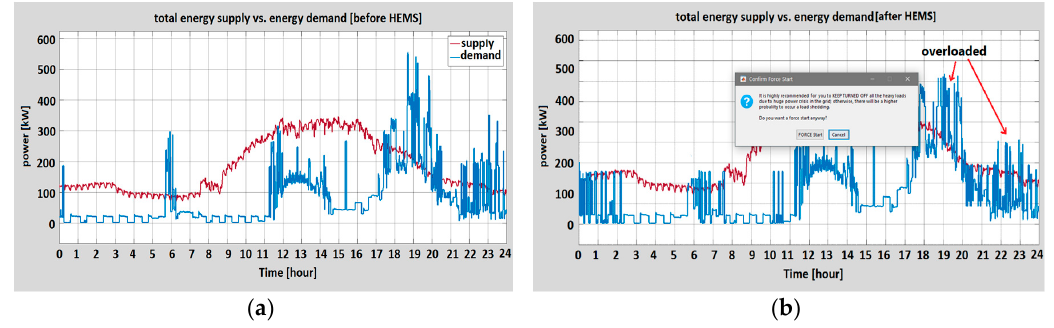
Figure 21. ( a ) Total energy supply and energy demand in Scenario B (Solar and Wind farm.) before HEMS, and ( b ) after HEMS.